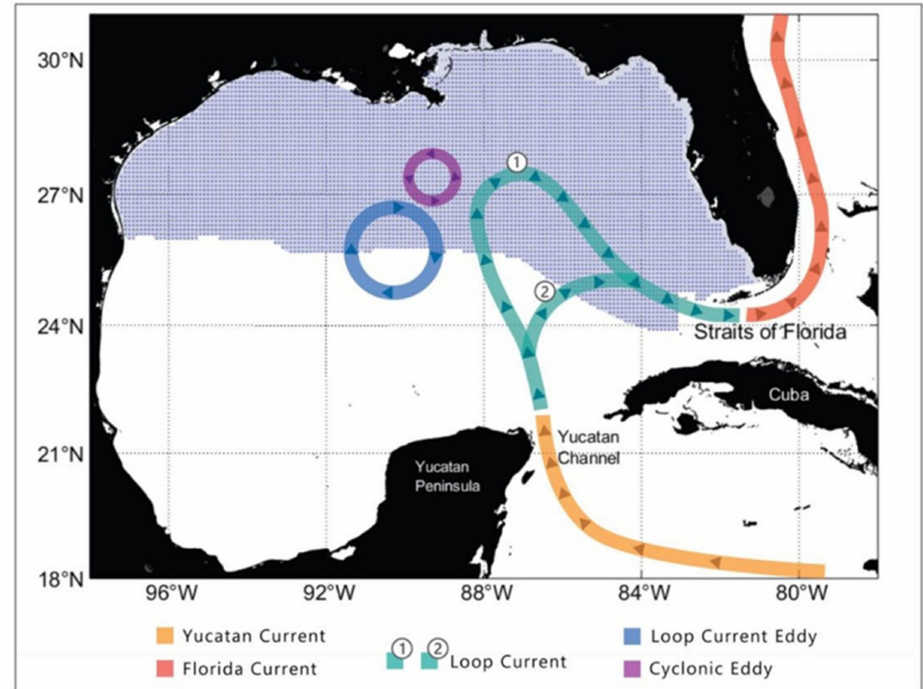
Figure 3. A schematic diagram showing the geographic map of the OSRA model domain, Gulf of Mexico (GOM) circulation patterns, and locations of hypothetical oil spills (blue dots)